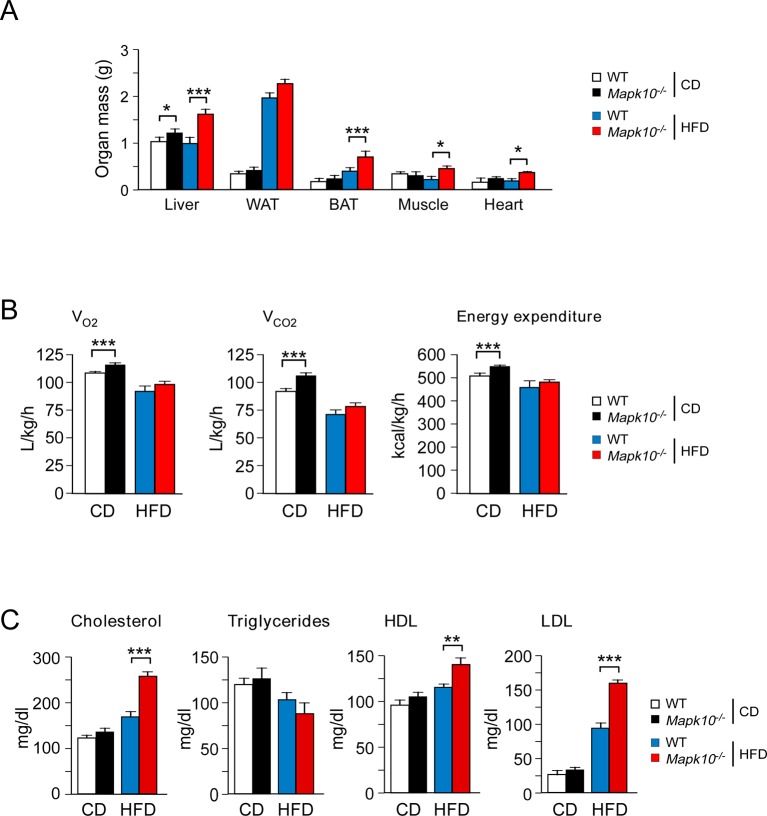
JNK3 deficiency causes obesity without changes in energy expenditure.(A) Organ mass of CD-fed and HFD-fed (12 wk) WT and Mapk10-/- mice was measured (mean ± SEM; n=10~12; *p<0.05; ***p<0.001). (B) CD-fed and HFD-fed (4 wk) WT and Mapk10-/- mice were examined using metabolic cages to measure VO2, VCO2, and energy expenditure (mean ± SEM; n=8; ***p<0.001). (C) Blood lipids and lipoproteins in overnight starved CD-fed and HFD-fed (12 wk) WT and Mapk10-/- mice were measured (mean ± SEM; n=10~12; **p<0.01; ***p<0.001).